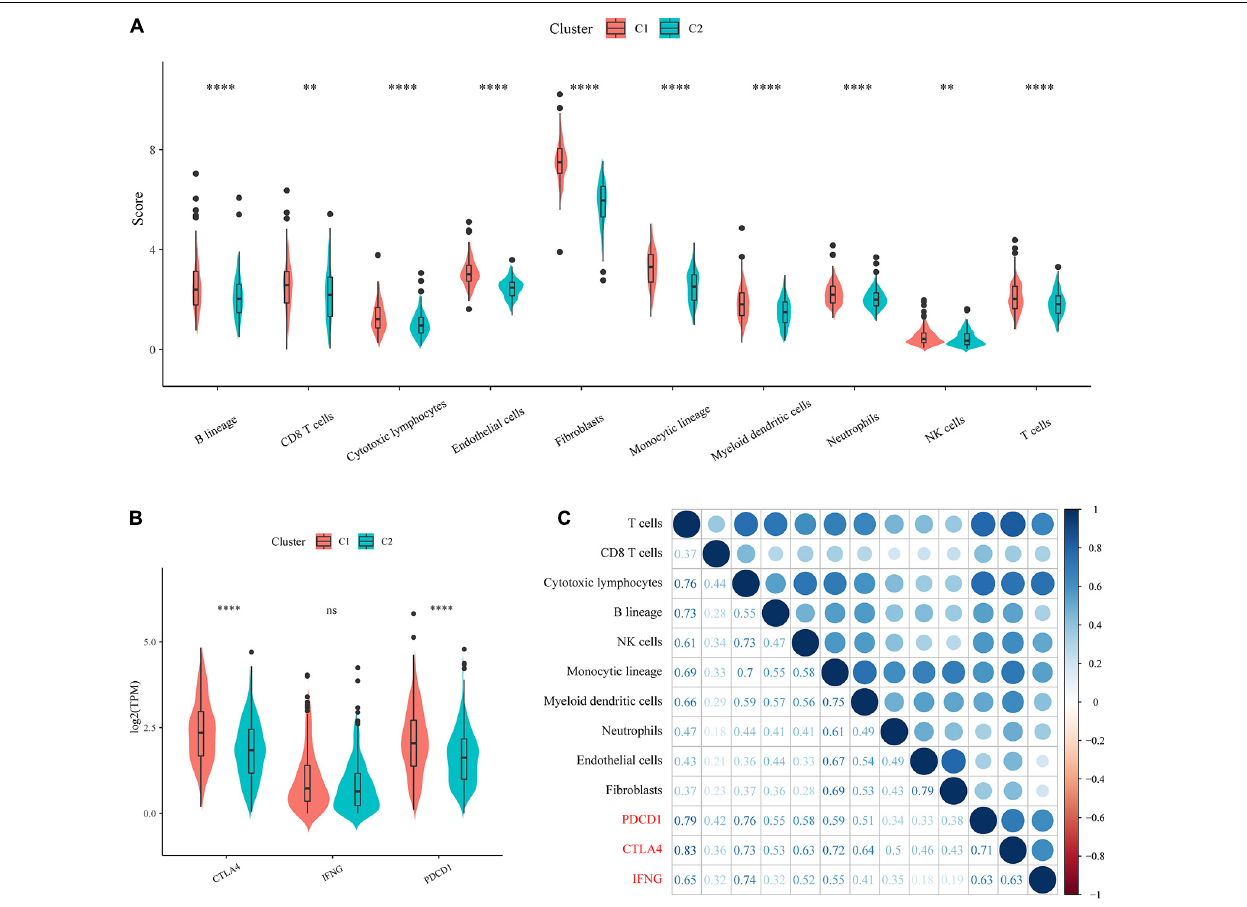
FIGURE 4 | Evaluation of immune cell scores and immunotherapy outcomes. (A) Comparison of immune scores and immune checkpoint gene expression between molecular subtypes. (B) Comparison of immune checkpoint gene expression between molecular subtypes. (C) Correlations of immune cell scores with immune-related